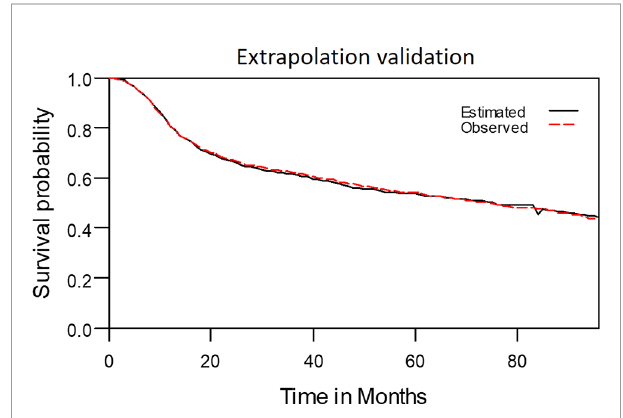
FIGURE 9 | The observed 8-year survival curve and the estimated 8-year survival curve matched